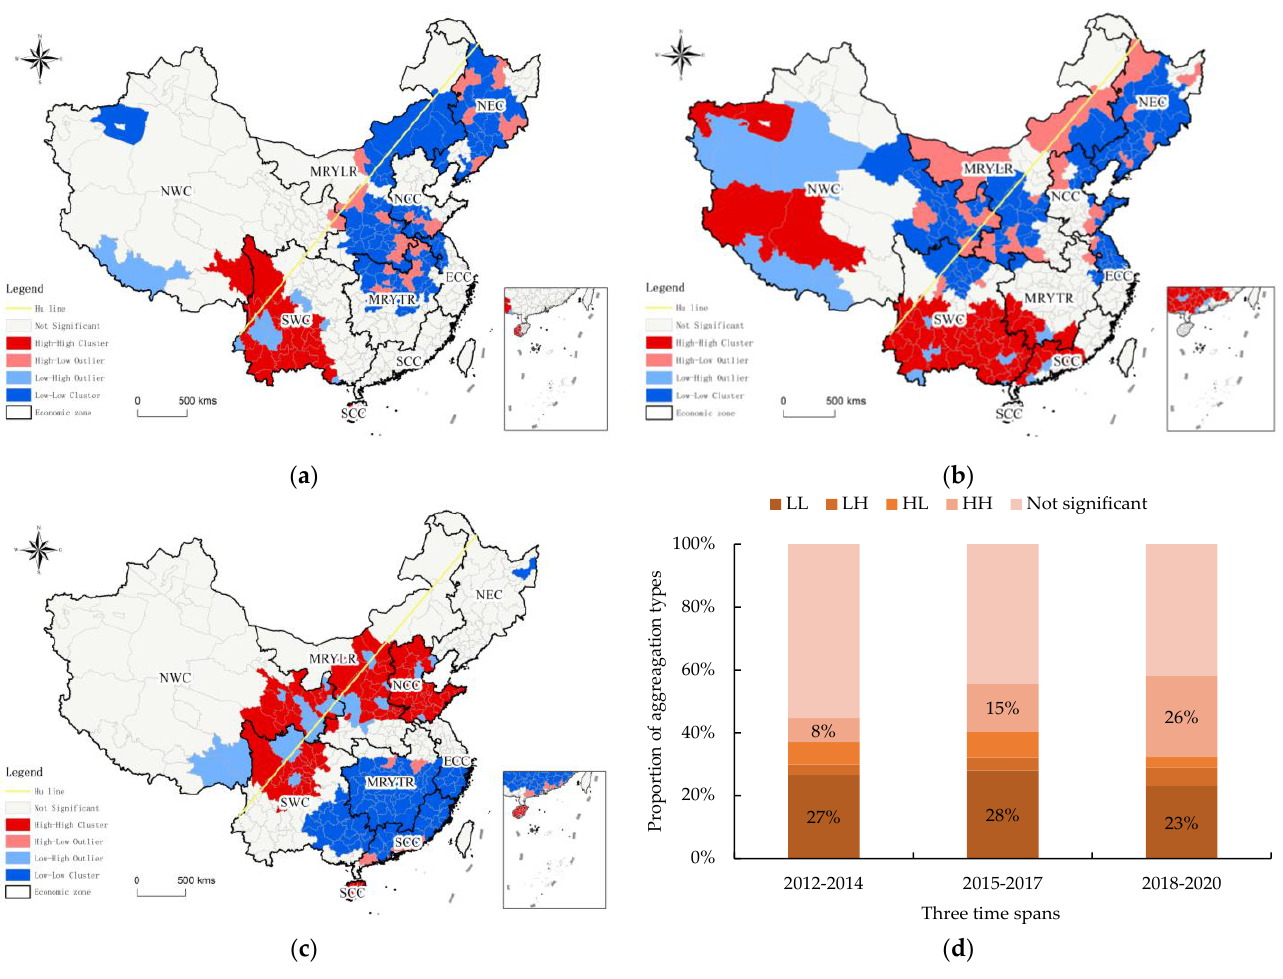
Figure 7 . Local Moran’s I of shrinking cities/growing cities from 2012 to 2020. ( a ) 2012 – 2014; ( b ) Figure 7. Local Moran’s I of shrinking cities/growing cities from 2012 to 2020. ( a )